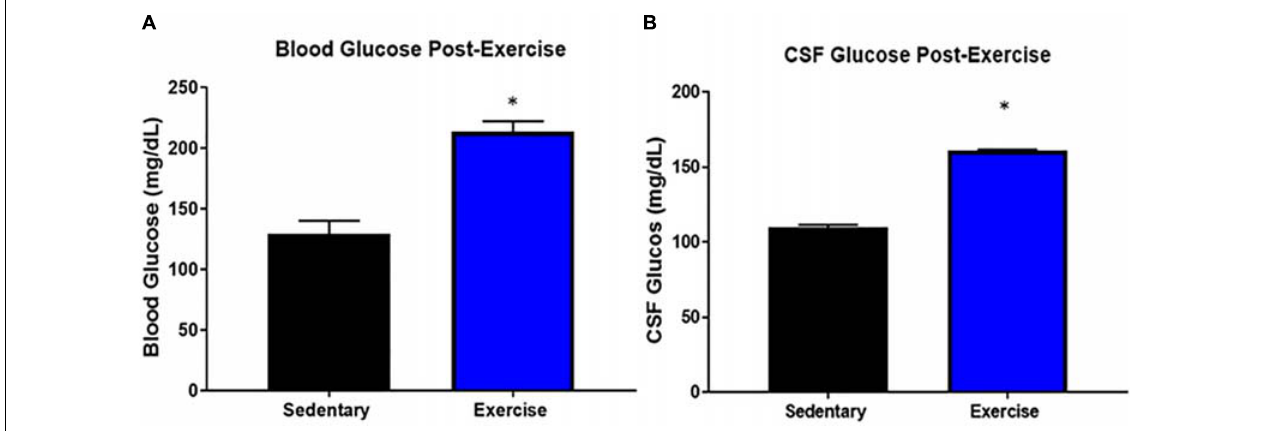
FIGURE 4 | Blood and CSF glucose levels were elevated immediately post-exercise. Average circulating glucose levels in (A) blood and (B) CSF of mice immediately after a bout of acute moderate-intensity exercise. Bar graphs show Mean + SEM. ( N = 3 male mice per group), * indicates p < 0.05 vs. sedentary group.